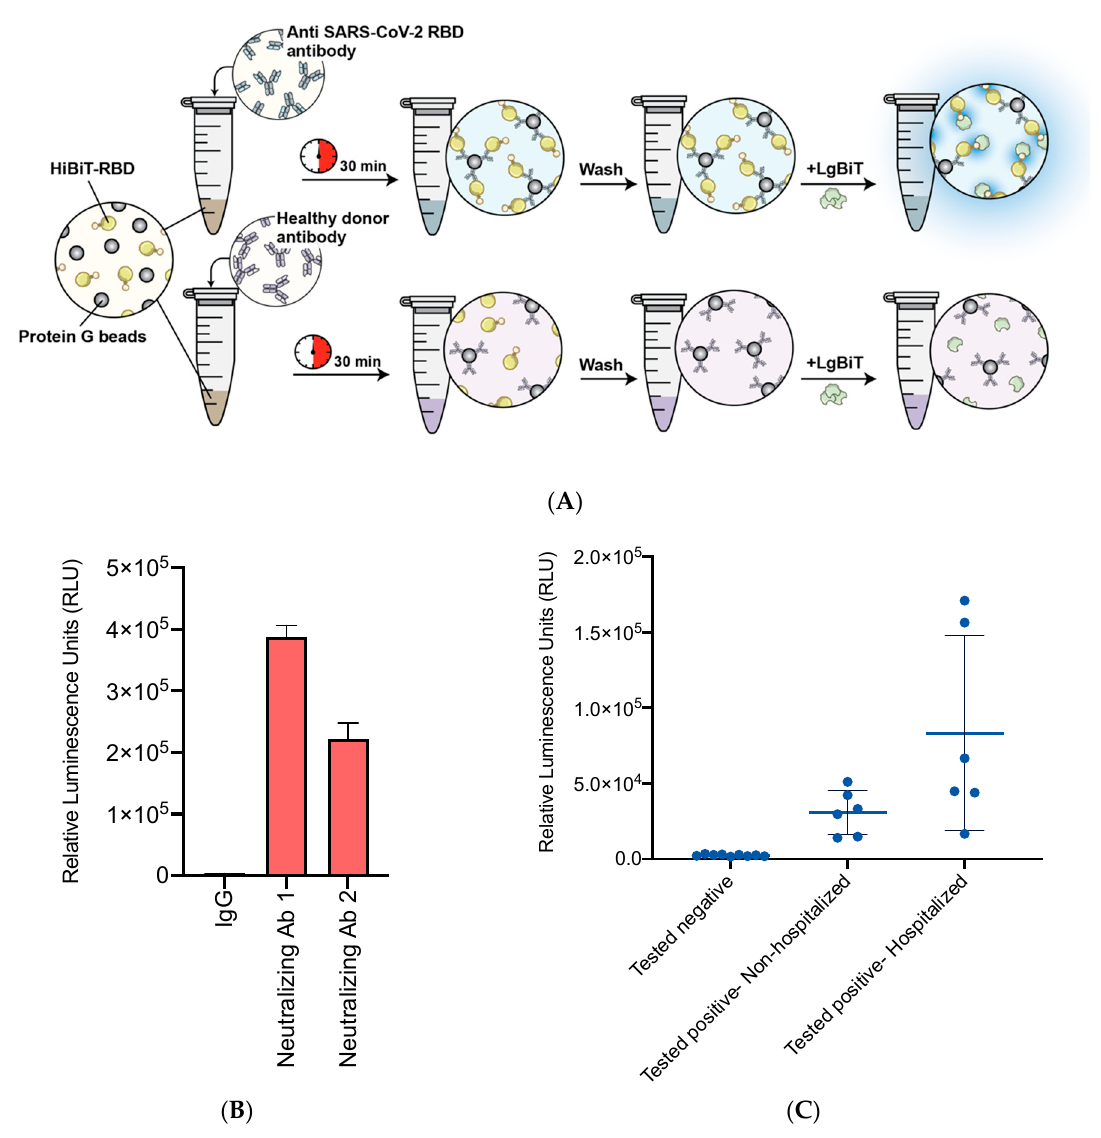
Figure 5. The detection of antibodies using the HiBiT-RBD serological assay. ( A ) Illustration of the NanoBiT serological assay. ( B ) High signal intensity and detection of the SARS-CoV-2 neutralizing antibodies compared to no signal for the control antibody. ( C ) Presence of signal in all positive patient cases and no false-positive results in negative samples. This experiment performed in the 96 well plates which showed the compatibility of the assay for high through put screening.